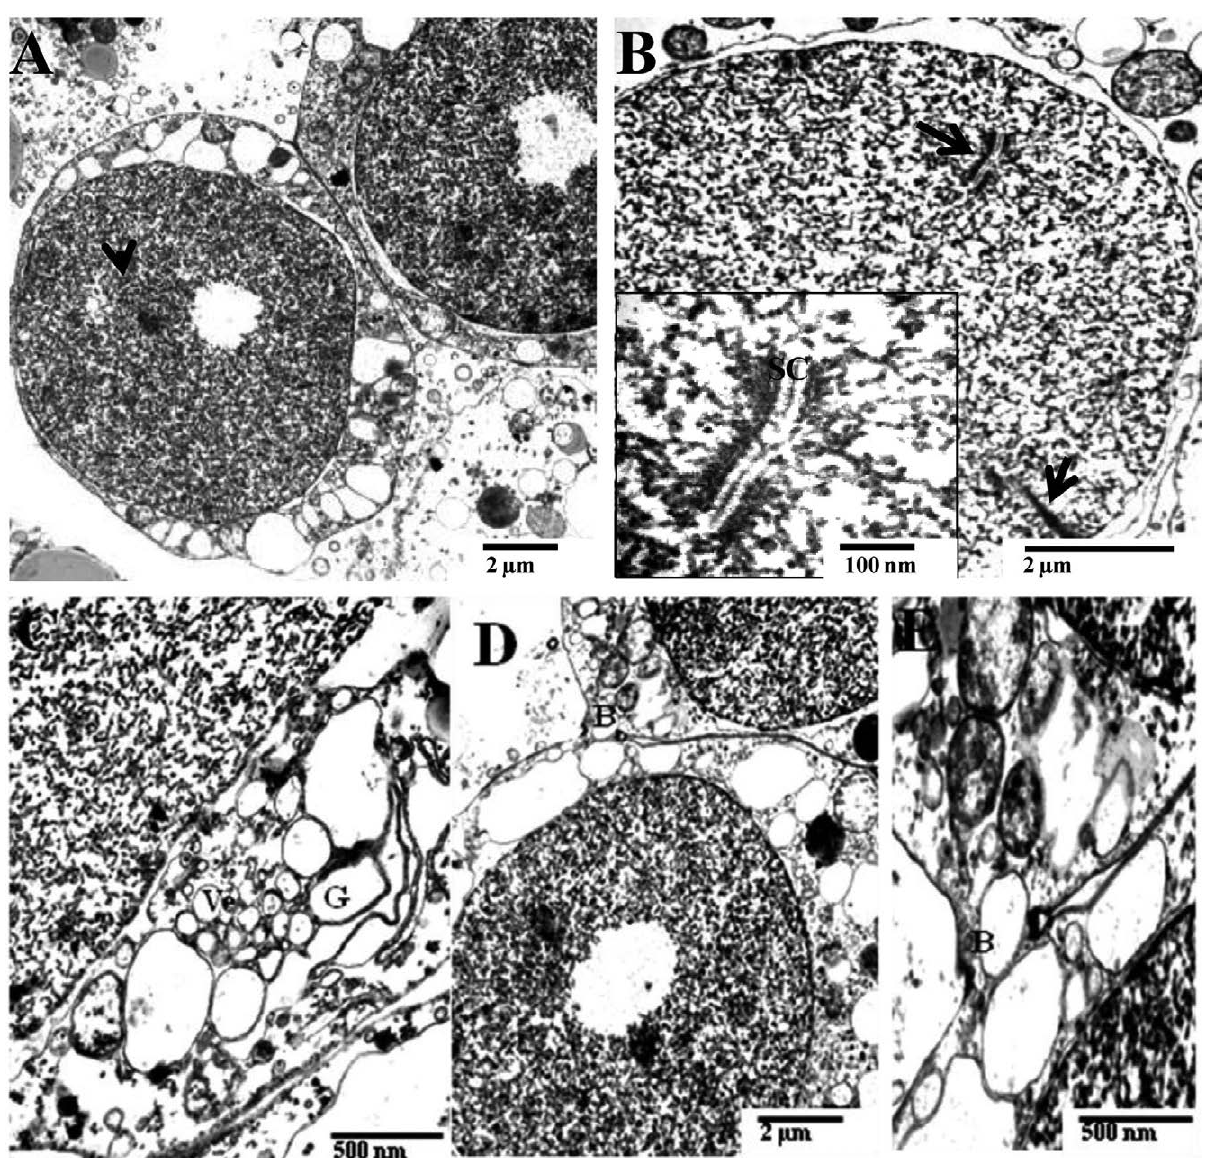
Fig. 4. – A, TEM of coelomic cluster of previtellogenic oocytes I ; arrowhead indicates homologous chromosomes. B, TEM of previtellogenic oocytes I showing paired chromosomes forming a synaptonemal complex (SC) (arrows); Inset: high magnification of a synaptonemal com- plex. C, Golgi complex in the ooplasm of a previtellogenic oocyte I; note the abundance of small and large vesicles (Ve) deriving from the Golgi complex (G) in the ooplasm. D, TEM of early previtellogenic oocytes connected by thin intercellular bridges (B). E, high magnification of intercellular bridges